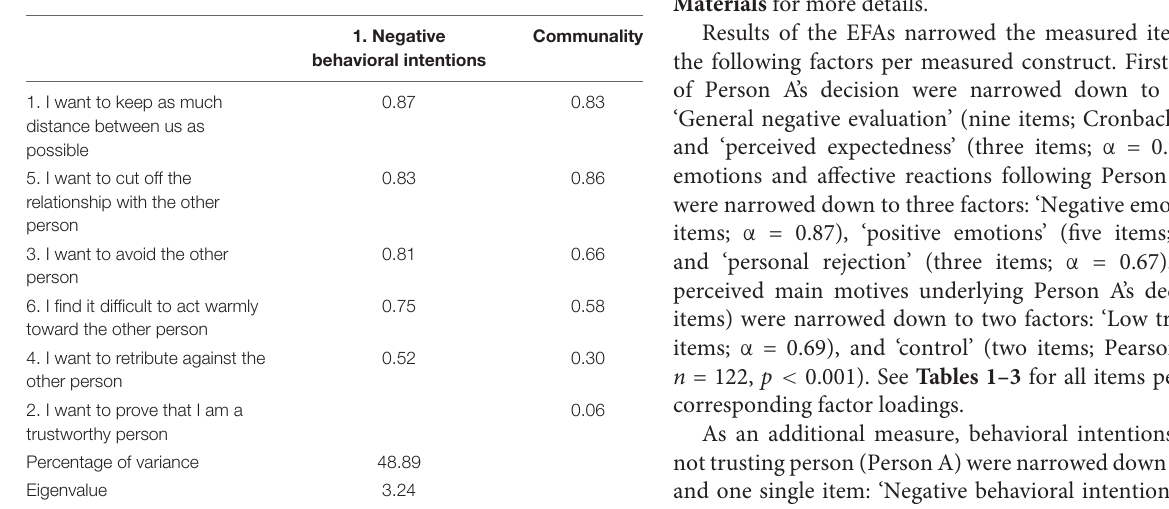
TABLE 4 | Factor loadings based on an exploratory factor analysis with a principal axis factoring and direct oblimin rotation on eight items measuring behavioral intentions ( N =